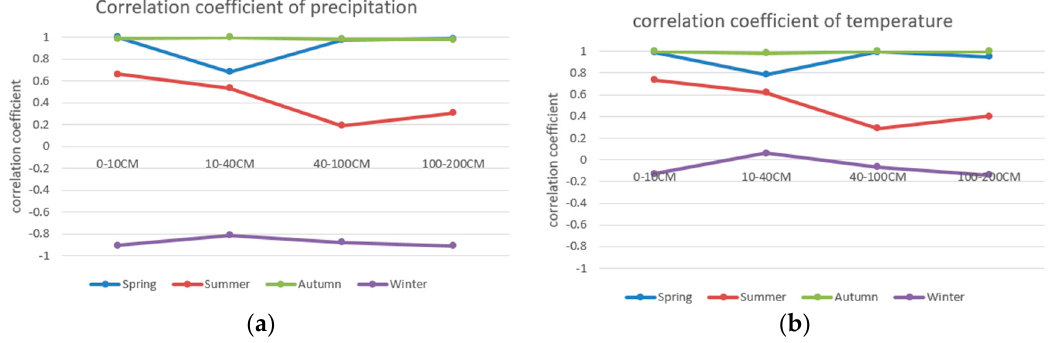
Figure 11. The correlation coefficient of precipitation and temperature with soil moisture in different seasons: ( a ) correlation coefficient of precipitation; ( b ) correlation coefficient of temperature.